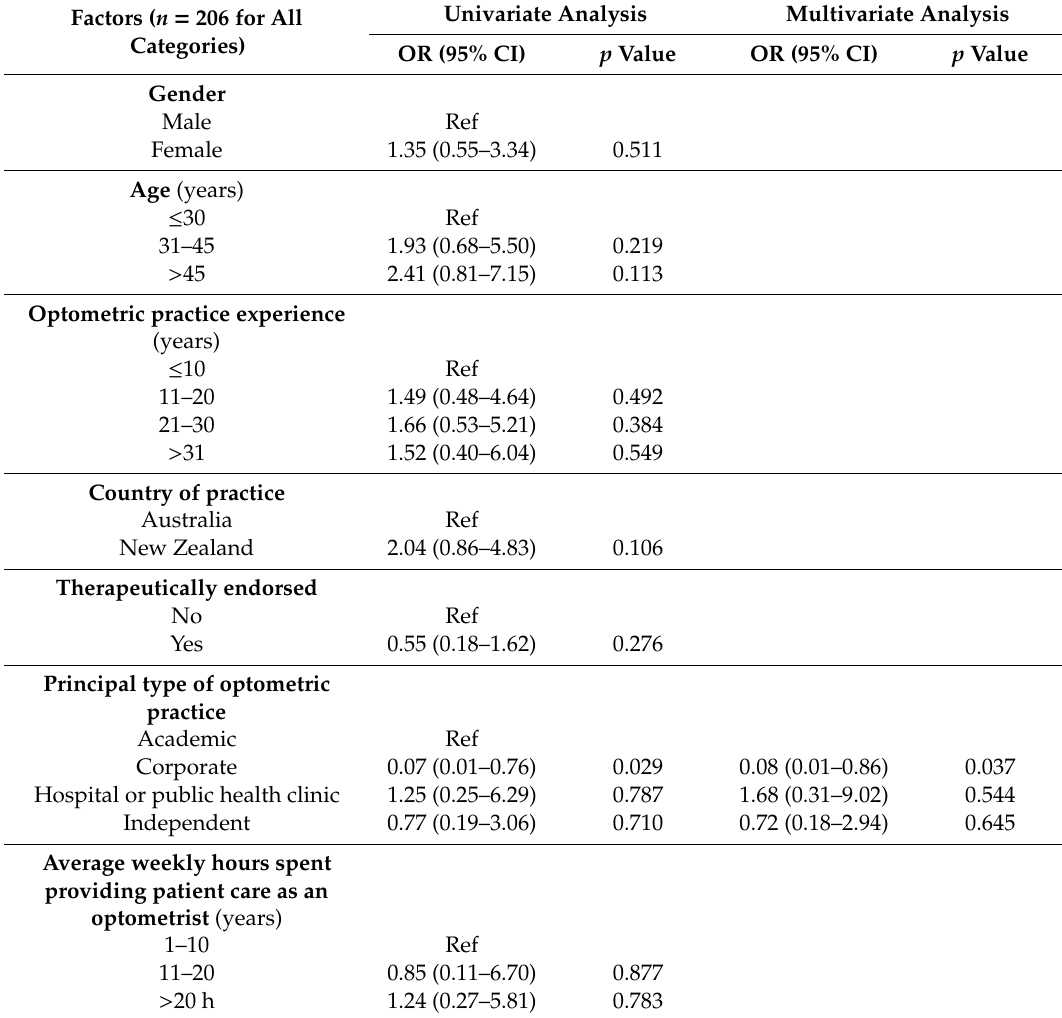
Table 4. Predictive factors for a ‘pass’ mark on the omega-3 knowledge score, relating to the accuracy of practitioners’ general knowledge about omega-3 fatty